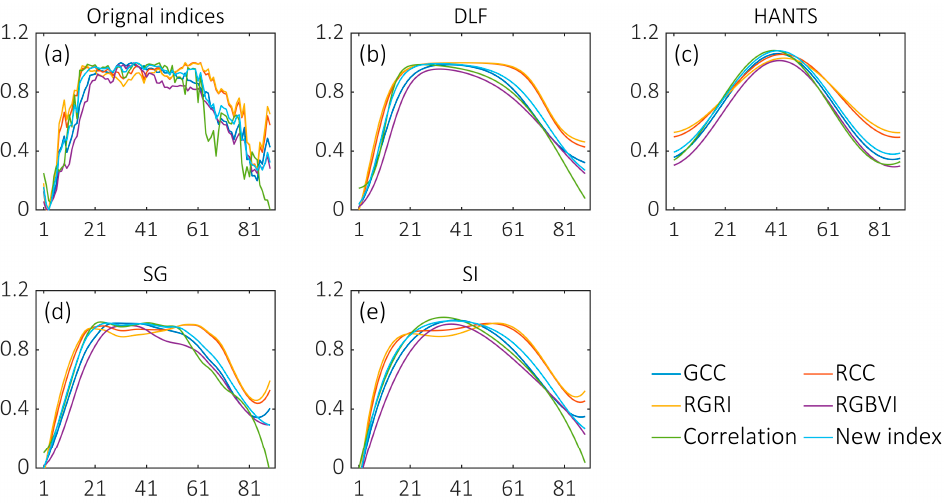
Figure 4. The comparison of original and filtered indices using DLF, HANTS, SG and SI. Note: the presented temporal changes in spectral indices and textural indices are based on Phenocam data obtained at Shangqiu in 2018. Note: ( a ) represented the original indices, and ( b – e ) represented the original indices filtered by DLF, HANTS, SG, and SI, respectively.